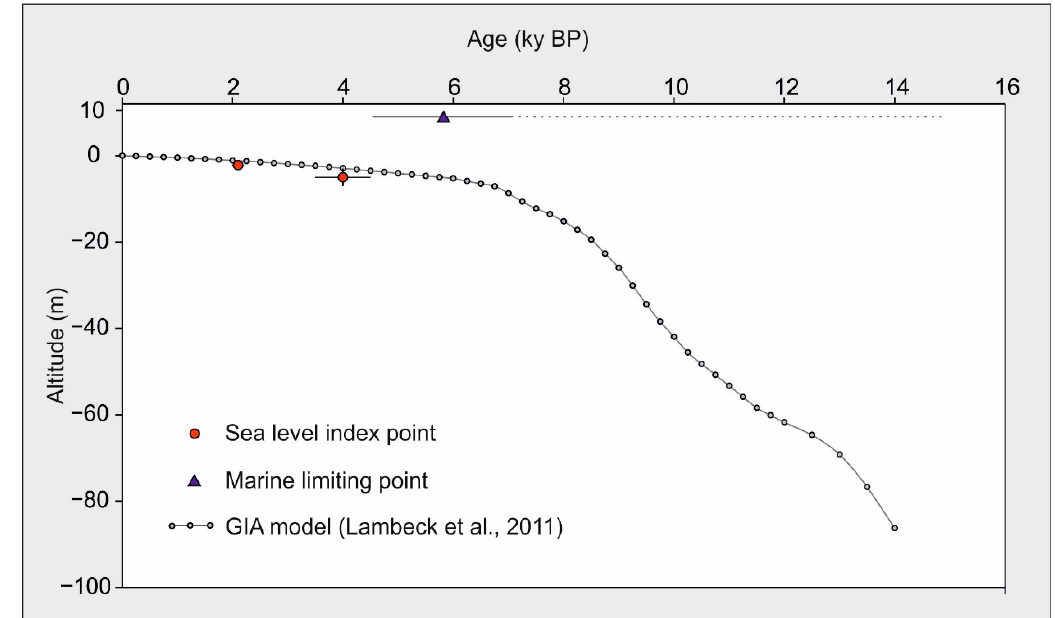
Figure 15. Relative sea-level curve for Naples in the last 6000 years. Black lines indicate the bi-directional uncertainty, but in the case of the marine limiting point related to the first order paleo-shore platform, the temporal uncertainty between 15 and 7 ky BP is a dotted line, because our interpretations led to discarding those millennia during which the rate of post-glacial sea-level rise was too fast to permit the formation of sub-horizontal wave-cut platforms.